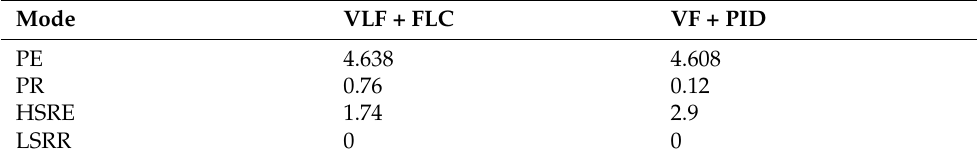
Table 6. Energy consumption on both control methods